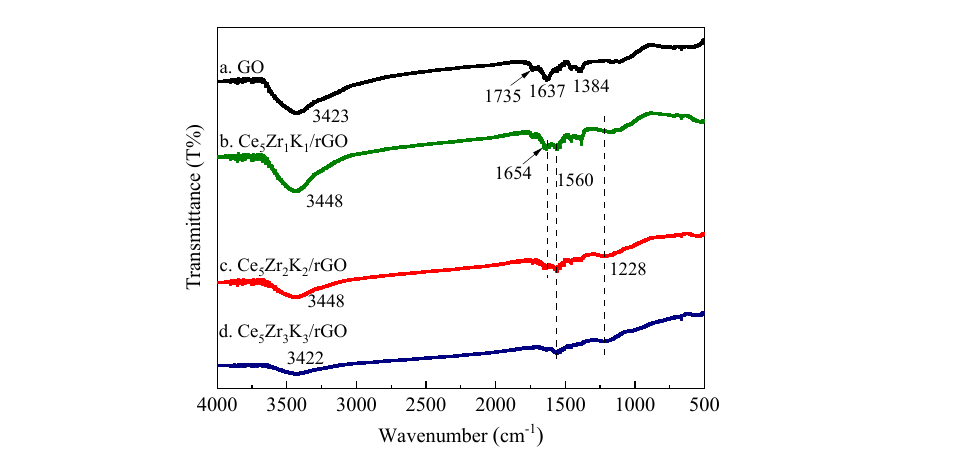
Figure 7. Fourier transform infrared spectrometry (FTIR) spectra of CeZrK/rGO catalysts and GO. The oxidation states of the main elements Ce, Zr, O and C, including an estimate